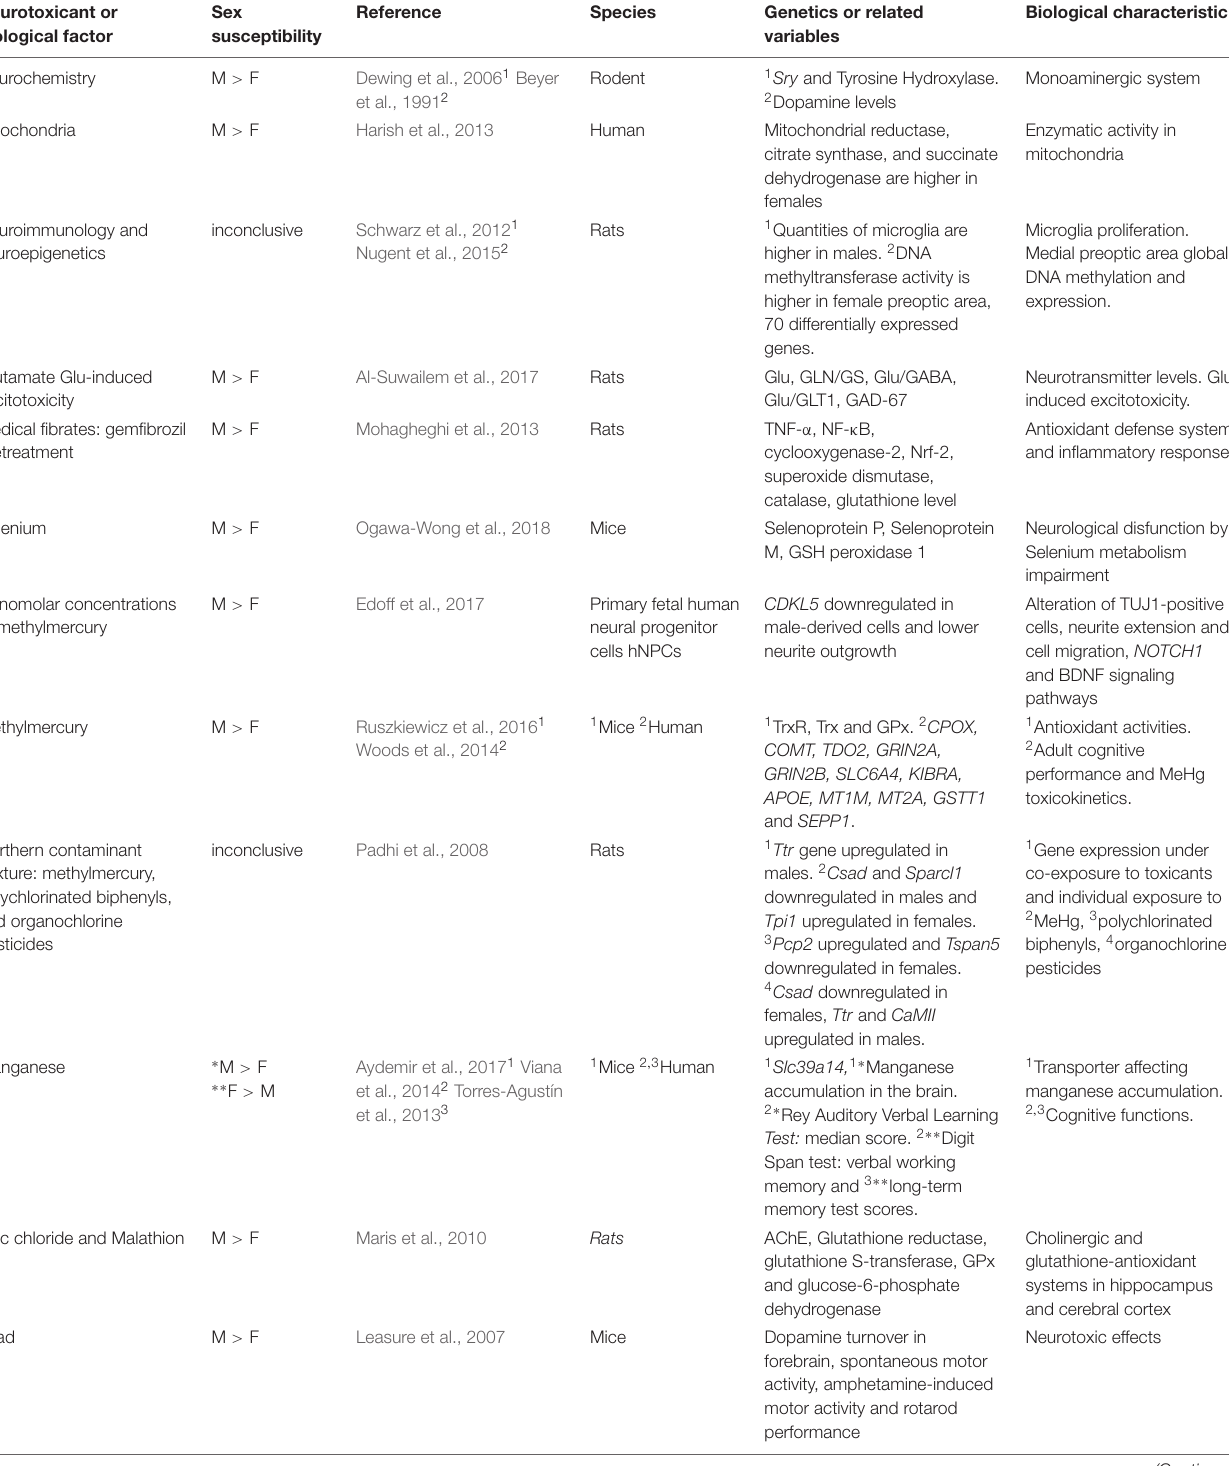
TABLE 1 | Sex susceptibility to toxicants and related biological factors that influence